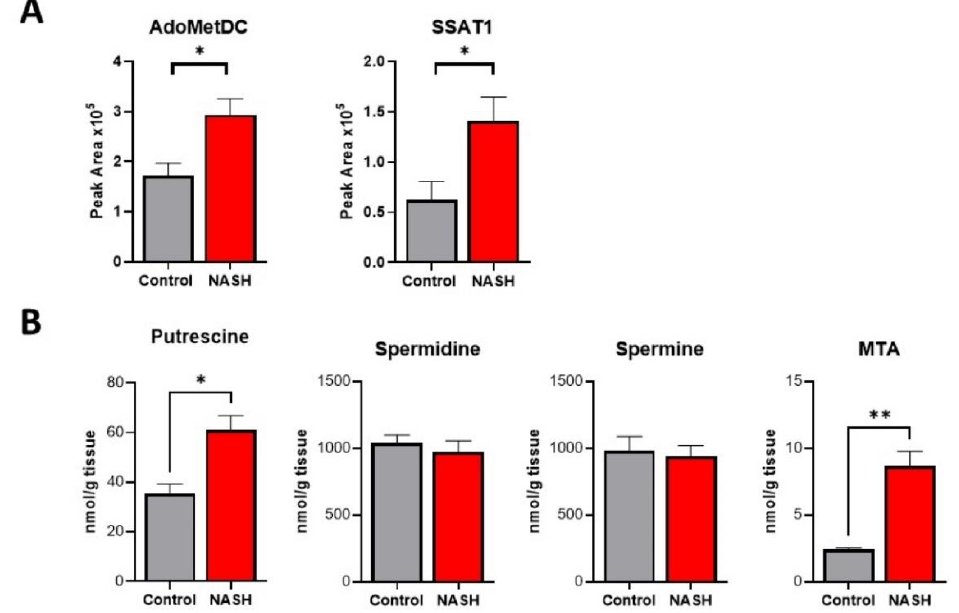
Figure 6. Polyamine metabolism is activated in NASH causing a flux. ( A ) Relative protein abundance of select polyamine metabolic enzymes in control and NASH livers. ( B ) Quantification of polyamine metabolites in control and NASH livers. Data presented as mean ± SEM (N = 4, ** p < 0.01, * p < 0.05).